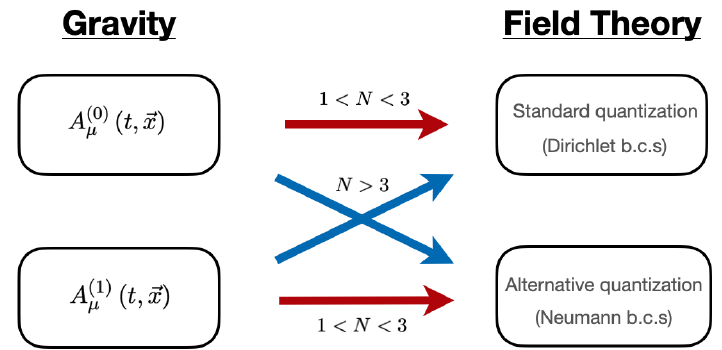
Figure 17 . A representation of the role of the gauge field coefficients at the asymptotic boundary and the quantization scheme in the dual field theory for different N